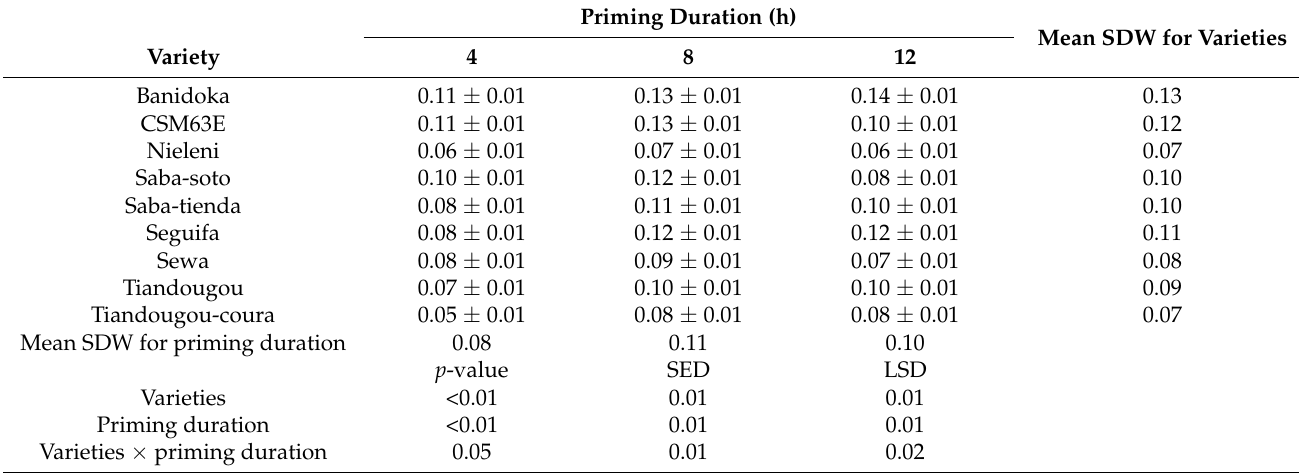
Table 7. Seedling dry weight of 9 sorghum cultivars presoaked under different priming duration in tepid water. Priming Duration (h) Mean SDW for Varieties Variety